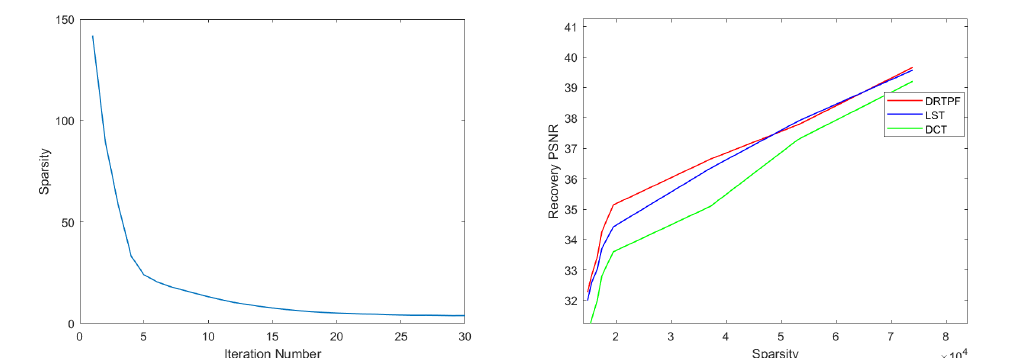
Figure 6. The average Sparsity and Recovery PSNR. Left : The X -label is the iteration number and the Y -label is the average sparsity. Right : The X -label is the average sparsity and the Y -label is the average Recovery